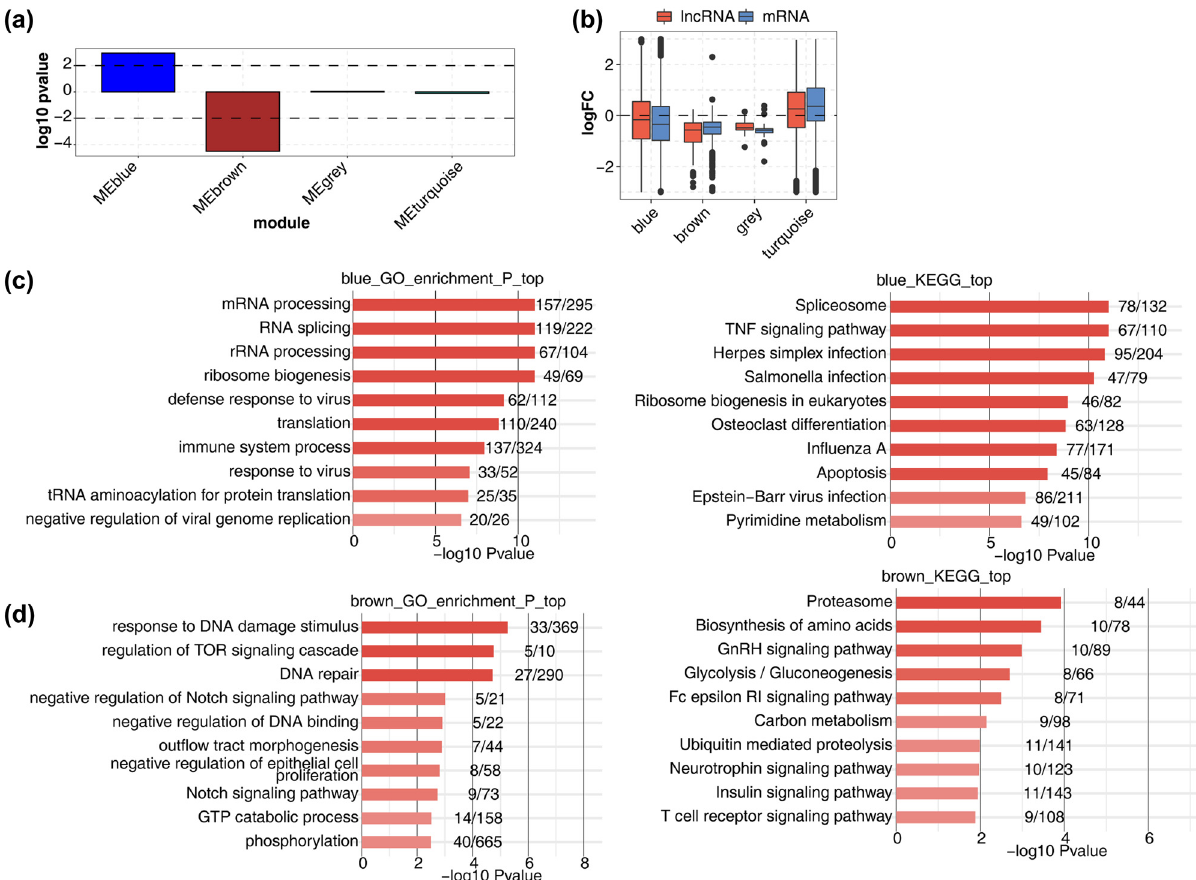
Figure 6: WGCNA of all expressed lncRNAs and mRNAs. ( a ) Signed association of module eigengenes with diagnosis of MI and Sham. Positive values indicate modules with increased expression in samples. Negative values indicate modules with decreased expression in samples. Dashed lines signify associated modules. ( b ) Boxplot showing expression fold change of mRNAs and lncRNAs from the four associated modules. The top 10 GO biological process and KEGG pathway enrichment of the modules MEblue ( c ) and MEbrown ( d )